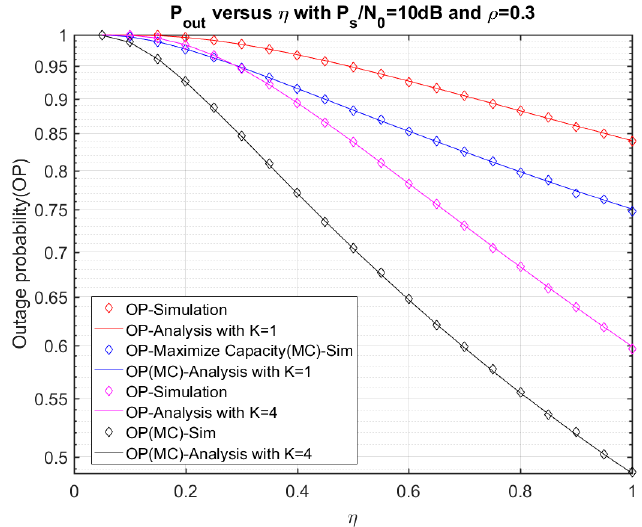
Figure 6. The outage probability versus η .